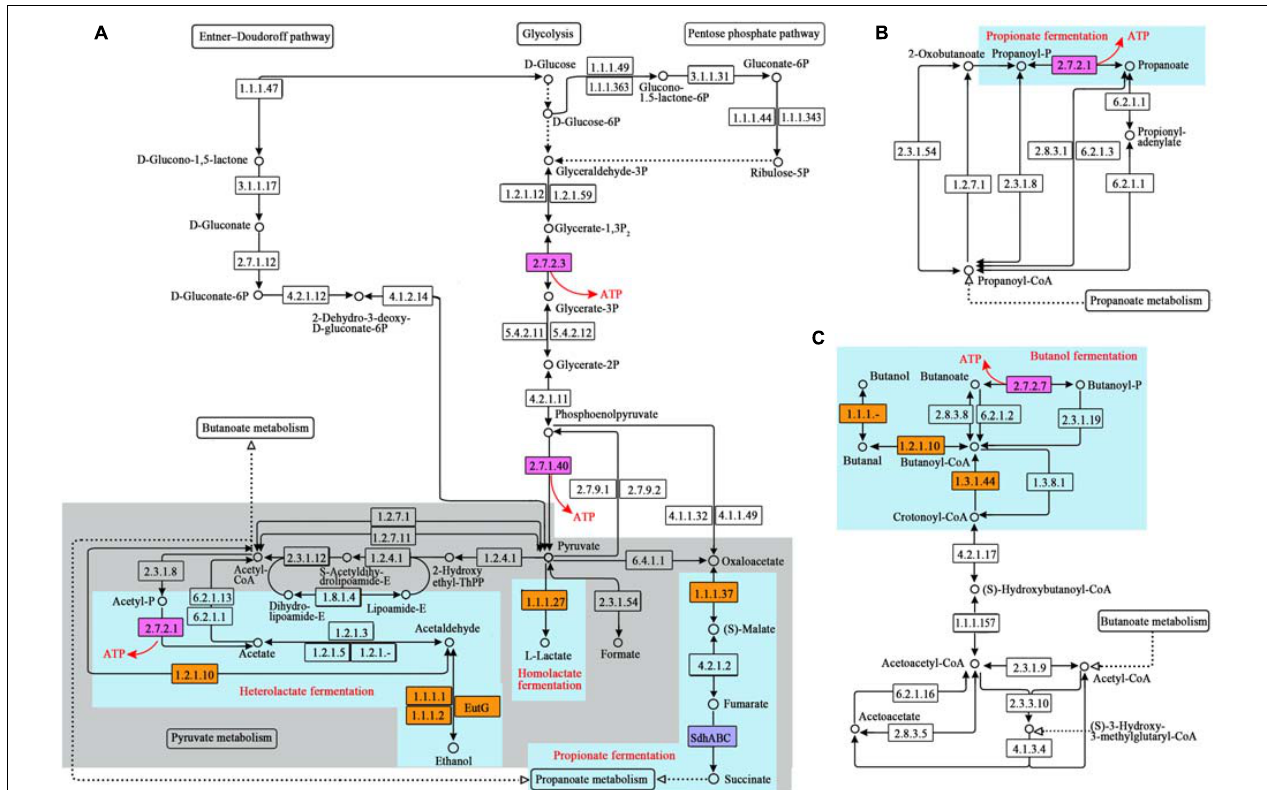
FIGURE 1 | SLP-related pathways reconstructed from the metagenome sequences of the ruminal microbiome. (A) Glucose metabolism; (B) propanoate metabolism; (C) butanoate metabolism. The numbers in the boxes represent the EC numbers of pathway enzymes. The box in pink refers to the SLP enzymes. The box in blue refers to the electron transporter. The box in yellow refers to NADH oxidase during glucose fermentation. Light blue background indicates the key steps of the specific fermentation pathway. ThPP is the abbreviation of meso-5, 10, 15, 20-tetra (4-hydroxylphenyl) porphyrin. KO numbers and gene annotation of the enzymes are shown in Supplementary Table 1